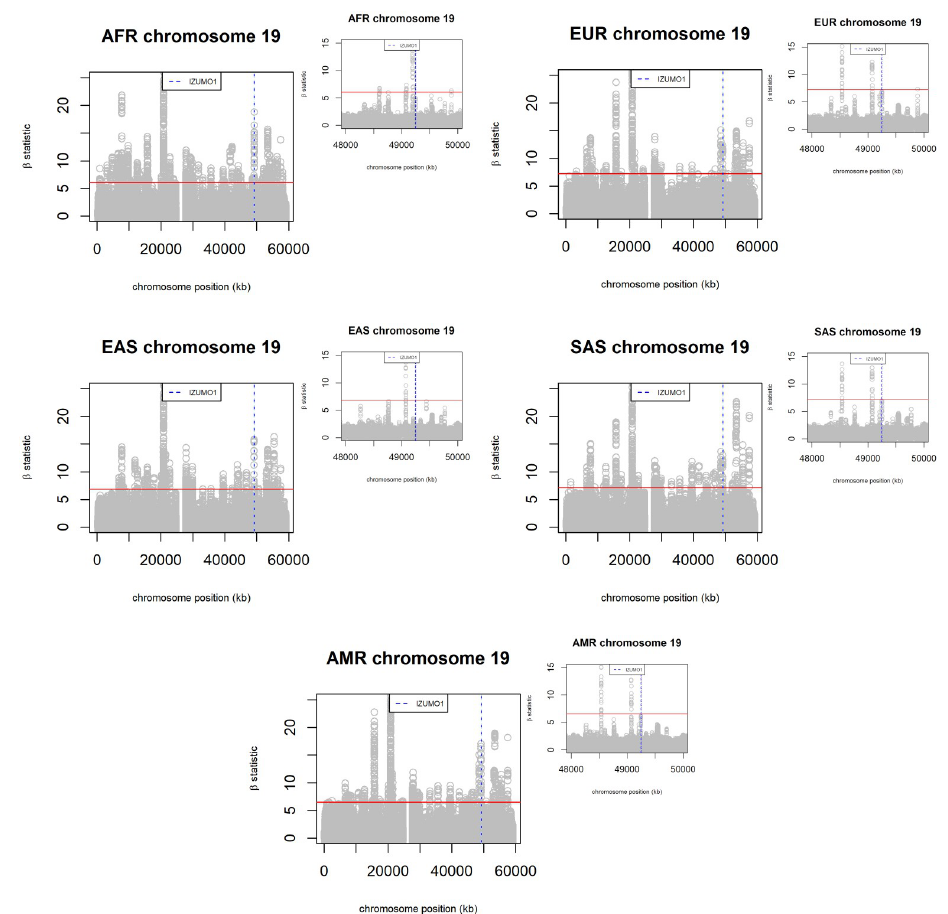
Fig 10. Scanning for signals of balancing selection om chromosome 19 of the AFR, EUR, AMR, EAS, and SAS populations of the 1000 genomes project. Regions with β scores above the 99.9% threshold (solid red line) are expected to be under balancing selection. The genomic region corresponding to the IZUMO1 gene is marked by blue dashed lines. For each population, the larger graph shows the distribution of β values throughout the entire chromosome, whereas the smaller graph focus on the vicinities of the IZUMO1